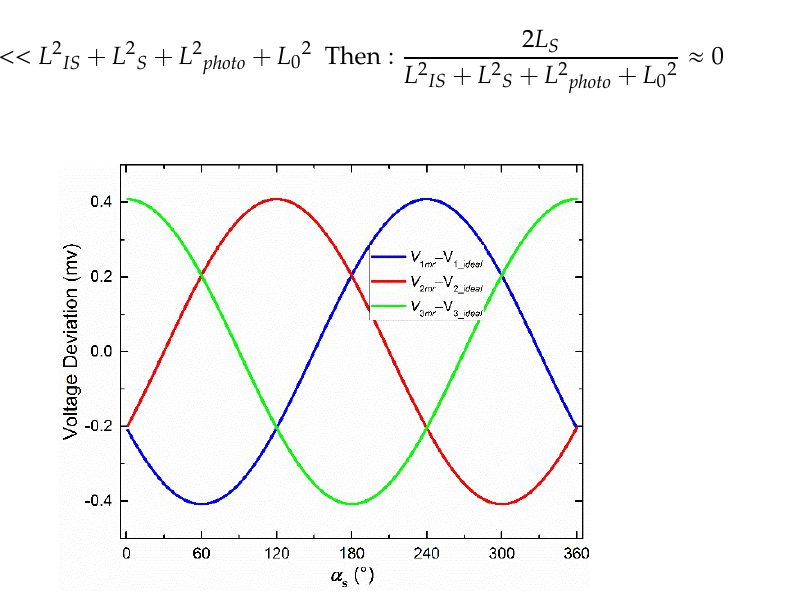
Figure 10. The influence of α S on the three voltage deviations after using the central-symmetry method. Fourth, the standard deviations of voltage deviations were used to evaluate the central-symmetry method, which does not change mathematical expectations. During a rotation of 360° with 1° intervals, the number of samples is 360. Standard deviations were investigated when L S and L IS were both between 0.001 and 1 mm. The standard deviations, before and after the central-symmetry method is used, are defined as BSD and ASD, respectively. ASD, the percent of ASD to BSD, the expectation, and the deviation percent of the expectation are shown in Figure 11, when L S is 1 mm and L IS is between 0.001 and 1 mm, and in Figure 12 when L S is between 0.001 and 1 mm and L IS is 1 mm, respectively. Only the first one of the three voltage deviations was chosen to be studied because of the similarity between them. α was set to be 240° because the corresponding S voltage deviation was the maximum, as shown in Figure 10. Figure 11. After using the central-symmetry method: ( a ) The influence of L IS on ASD and percent; ( b ) the influence of L IS on expectation and deviation percent.